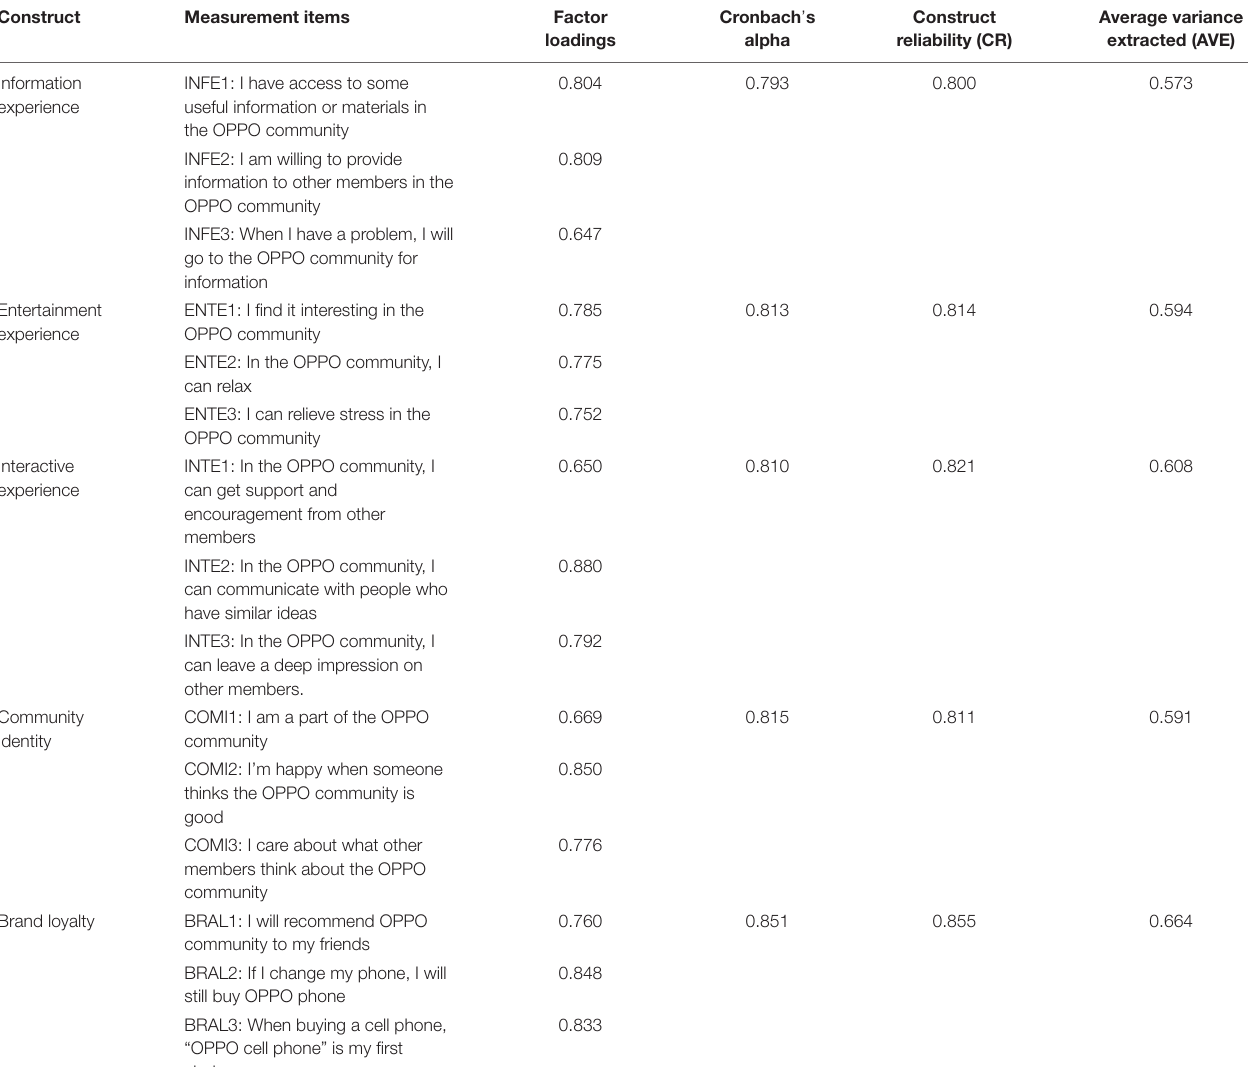
TABLE 2 | Confirmatory factor